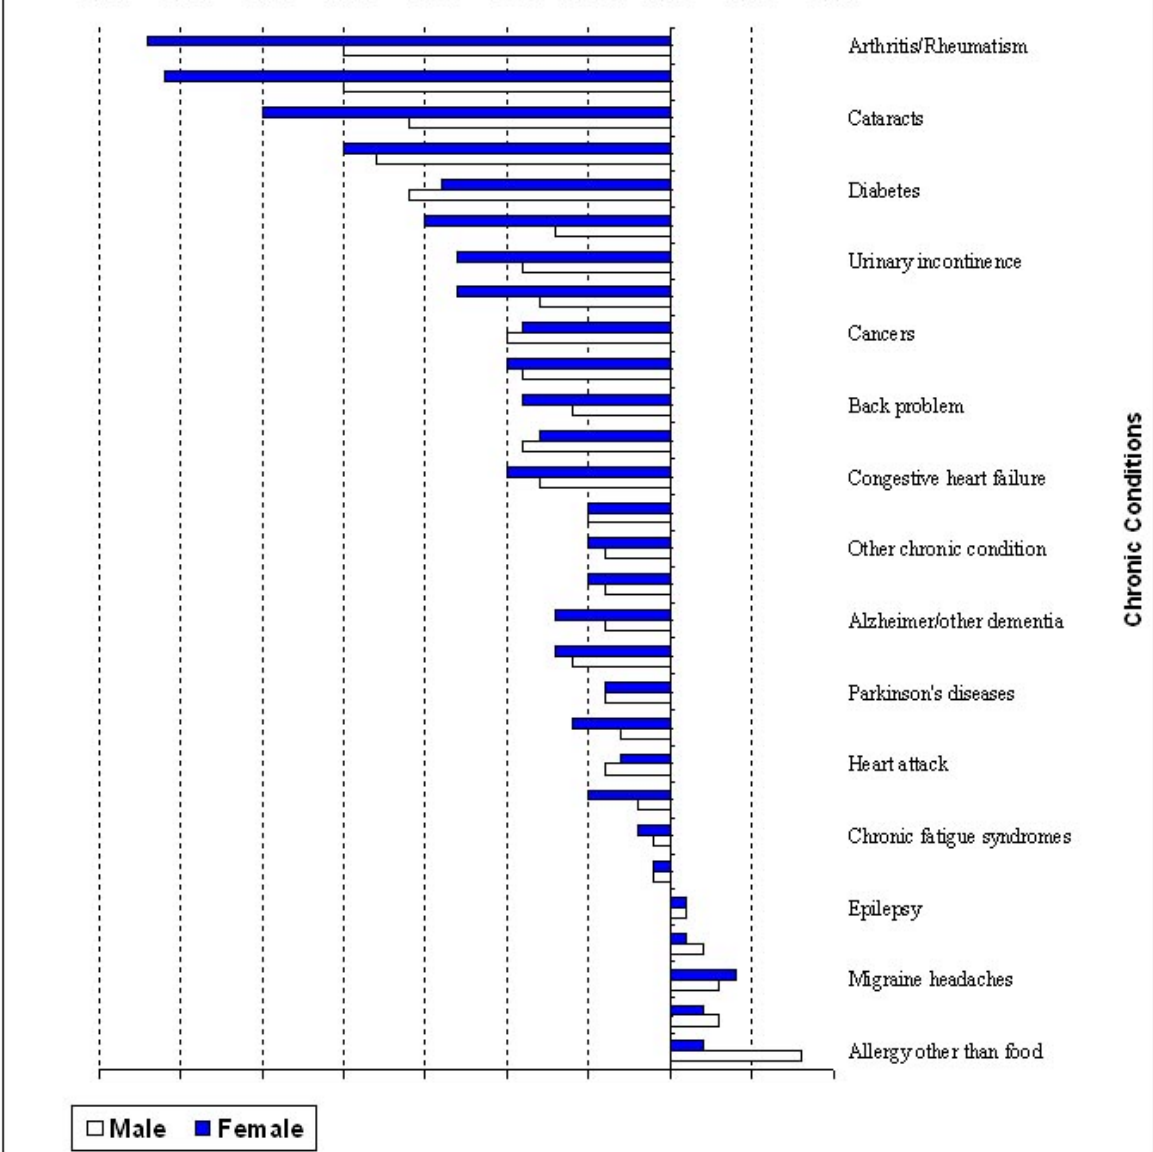
The impact on HRQL of some chronic conditions appear to be greater among those aged 65 and over, compared to those in younger age groups. The OR and p values were relatively high for effects of stroke (OR = 4.89, p = 0.001), emphysema/COPD (OR = 3.19, p = 0.001), Alzheimer/other dementia (OR = 2.30, p = 0.001), Parkinson’s disease (OR = 2.18, p = 0.001), cataracts (OR = 2.14, p = 0.001), chronic bronchitis (OR = 2.05, p = 0.001), high blood pressure (OR = 1.83, p = 0.001), and diabetes (OR = 1.69, p = 0.001). However, in contrast, there was high impact on HRQL for the younger age group (12–39 years) of urinary inconvenience, arthritis/rheumatism, food allergy, epilepsy, and back problems. Comparing the sexes, the impact on quality of life for males was relatively high for chronic fatigue syndrome (OR = 14.50, p = 0.001), multiple sclerosis (OR = 10.96, p = 0.001), diabetes (OR = 4.87, p = 0.001), and asthma (OR = 1.70, p =0.001) (Tables 2,